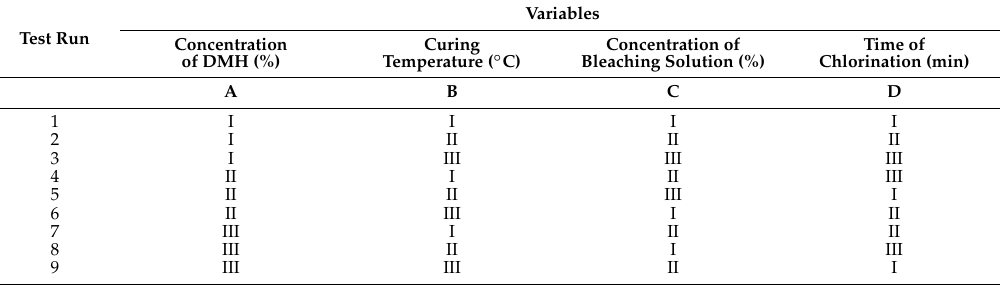
Table 2. Arrangement of experiment